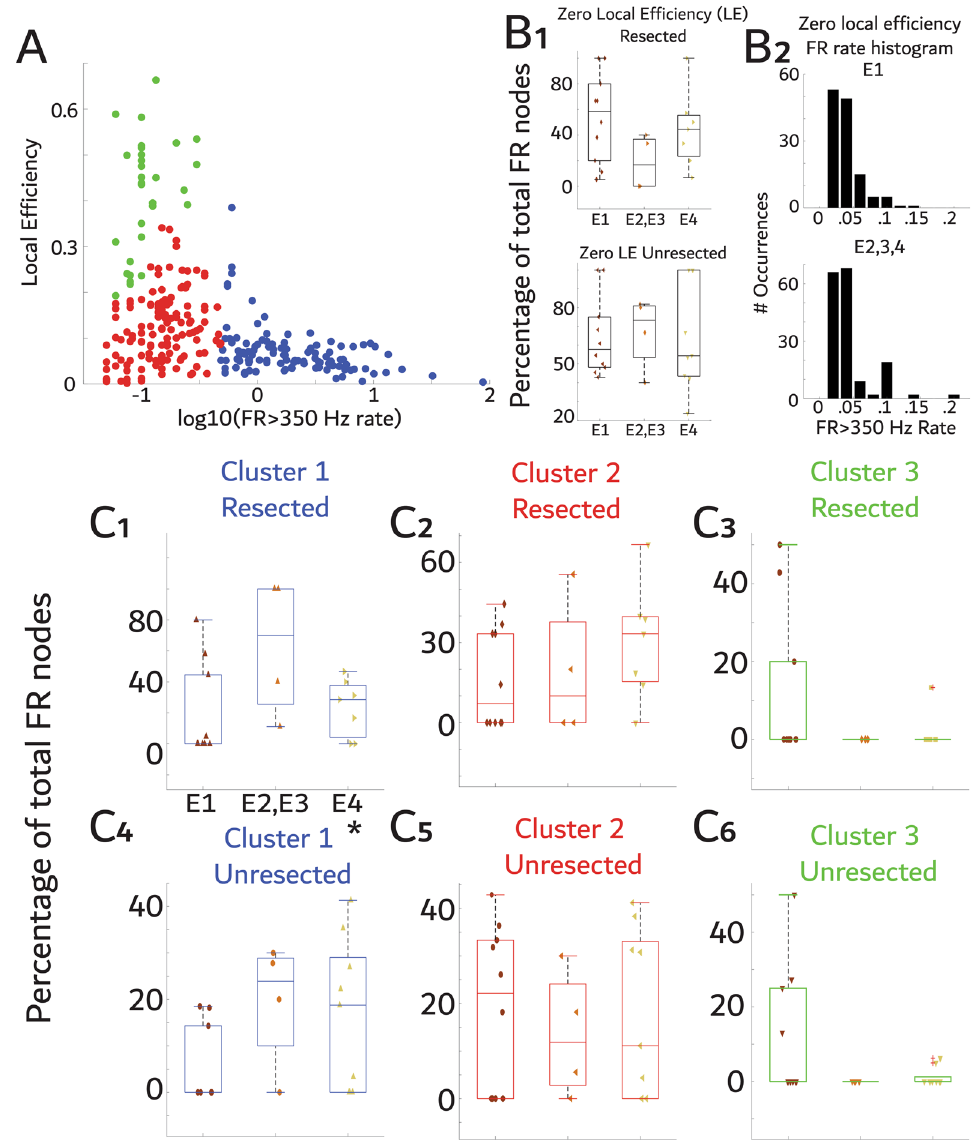
Figure 6. Failure to resect nodes with high FR rates and low local efficiency ( i.e. , FR desynchrony) correlates with poor surgical outcome. ( A ) Comparison of local efficiency (LE) with FR rate. K-means clustering identified three distinct clusters of nodes. ( B1 ) Percentage of resected (top) and unresected (bottom) nodes, within patients, with FR but zero LE (i.e., disconnected and not shown in panel A) for all the patients in the study cohort stratified by outcome. The percentage of zero LE nodes resected or unresected did not correlate with outcome (spearman, p > 0.05). ( B3 ) Histogram of FR rate in the nodes with zero local efficiency stratified by seizure freedom showing no marked differences. ( C1-3) The percentage of nodes, within patients, in the resection cavity belonging to each cluster shown in panel A: cluster 1 members (blue, C1); or cluster 2 members (red, C2 ); or cluster 3 members (green, C3 ) stratified by outcome. ( C4-C6 ) as in C1-C3 but for unresected nodes. Only cluster 1 unresected nodal percentage was statistically correlated with outcome (C4, asterisk, Spearman, p < 0.05). Notably, some of the E1-3 patients also showed relatively higher cluster 1 values in resected nodes ( C1